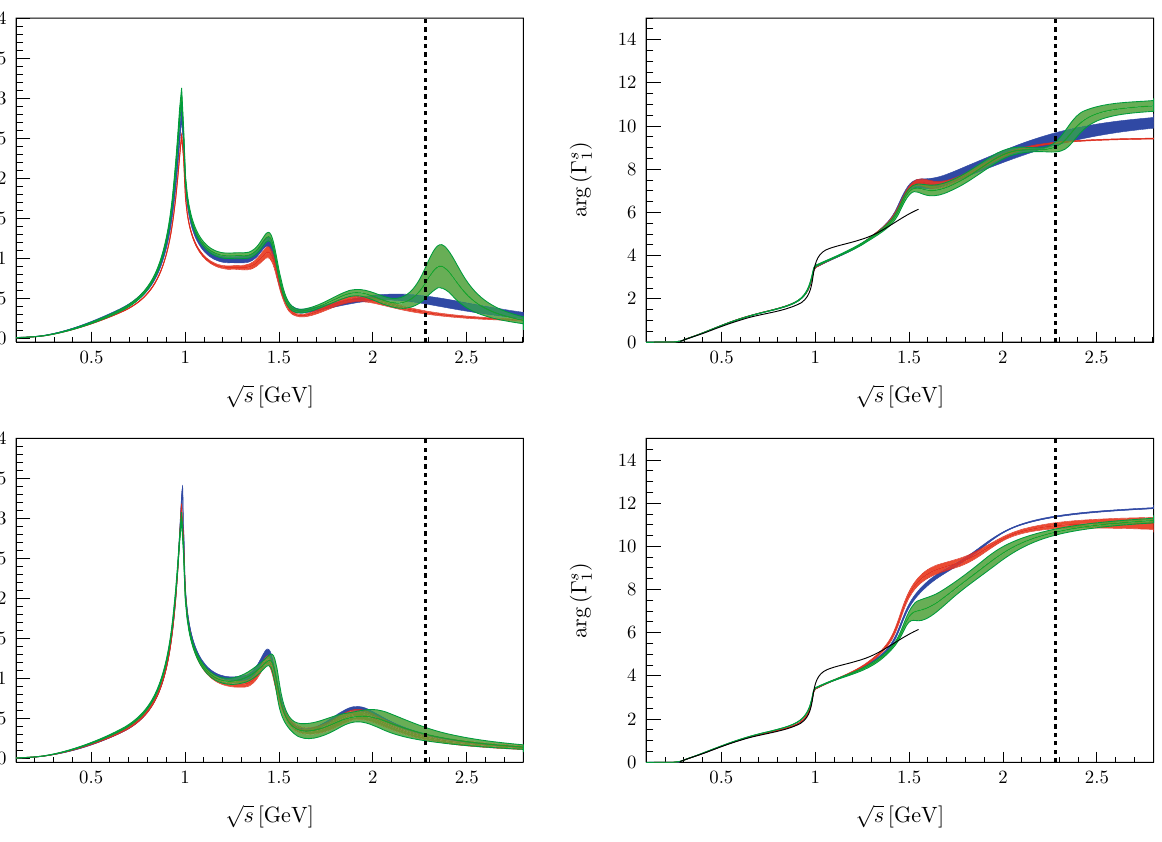
Fig. 6 Modulus (left) and phase (right) of the pion form factor Γ s the fits with an additional ρρ (top) and σσ (bottom) channel. The input scalar isoscalar scattering phase δ 0 is depicted in black. Fit 1 is shown